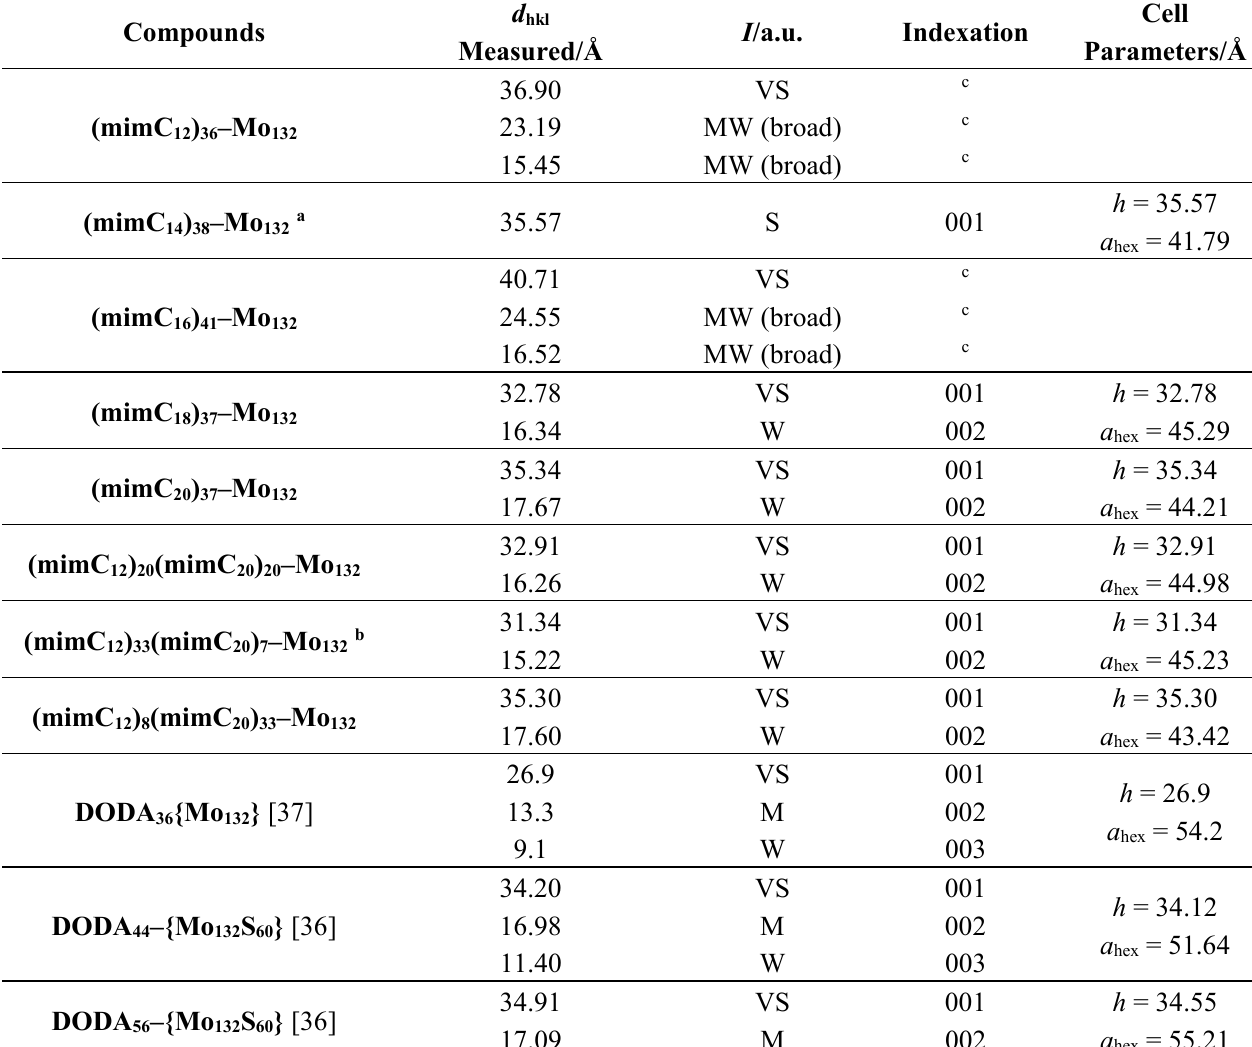
Table 3. Indexation at 200 °C during the cooling mode for the re flections detected in the liquid-crystalline phase by